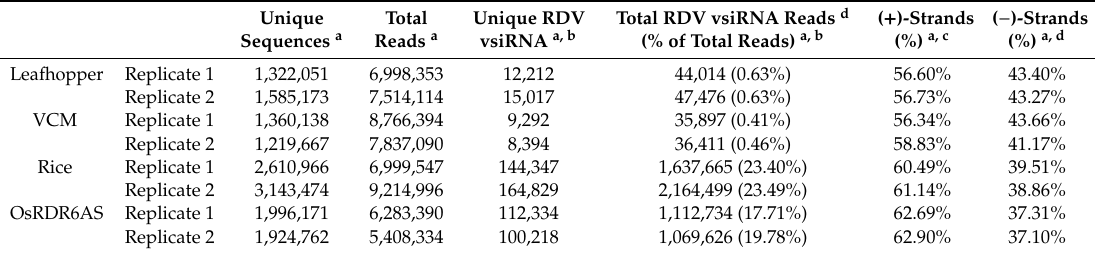
Table 1. Summary of deep sequencing results of small RNAs from RDV-infected leafhoppers, VCMs, and rice plants. Unique Sequences